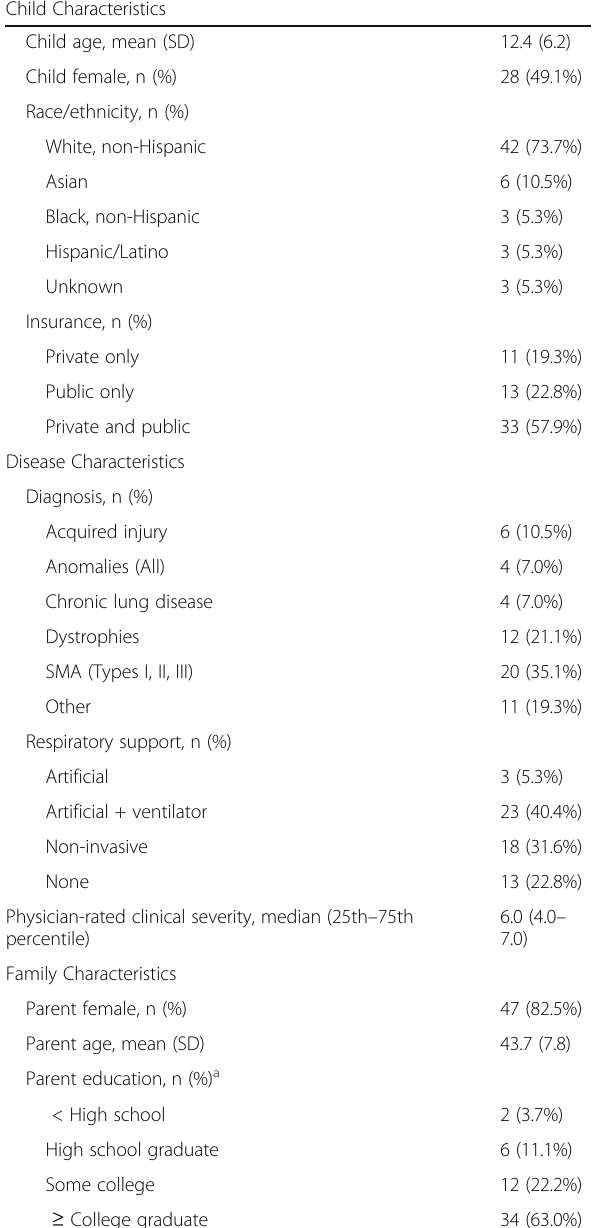
Table 1 Baseline Demographic and Clinical Characteristics, n =